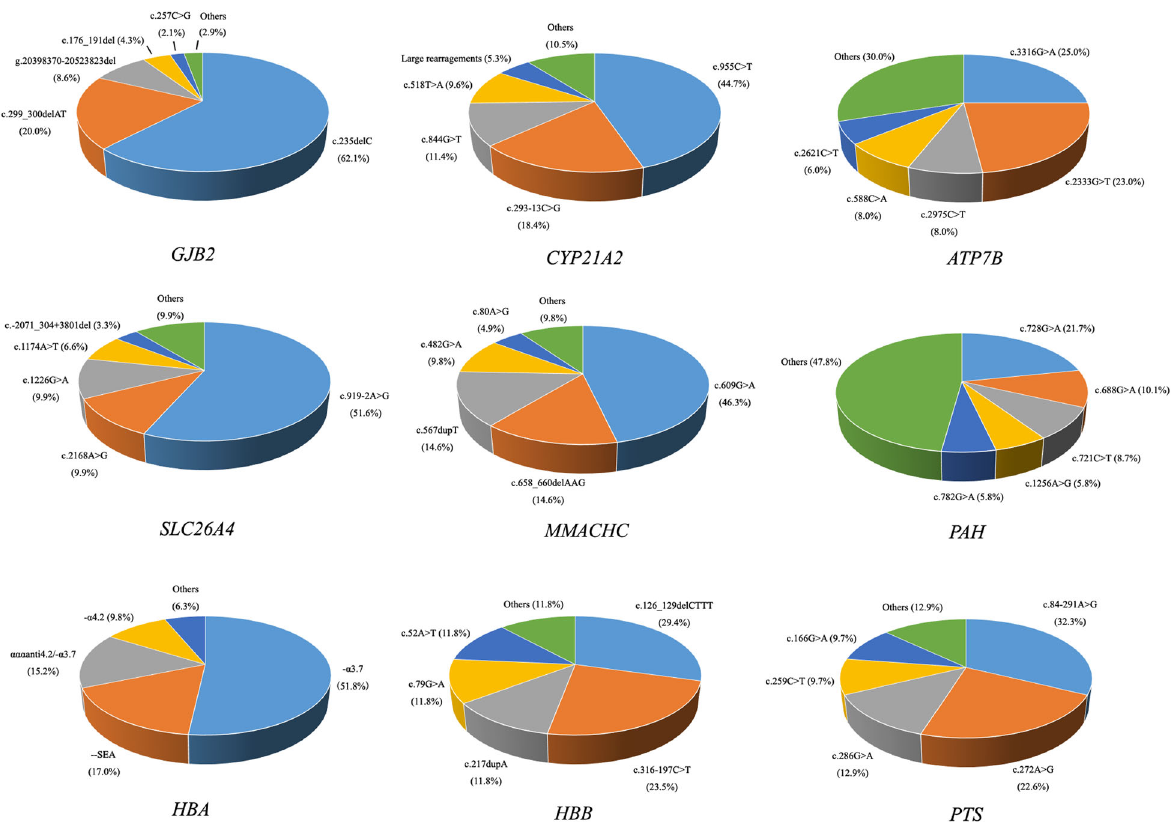
Fig. 3 The percentages of each variant in nine genes detected by CEBMPA. The mutational spectrum of GJB2, CYP21A2, ATP7B, SLC26A4, MMACHC, PAH, HBA, HBB and PTS in 1915 couples (3830 individuals).